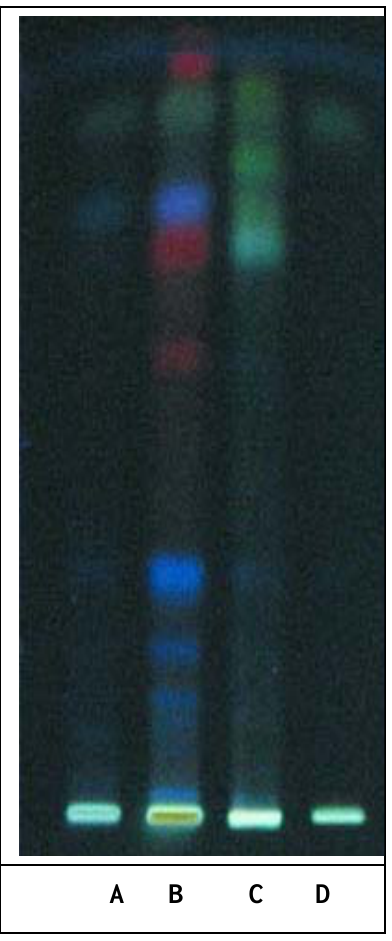
SO solution thus 2 4